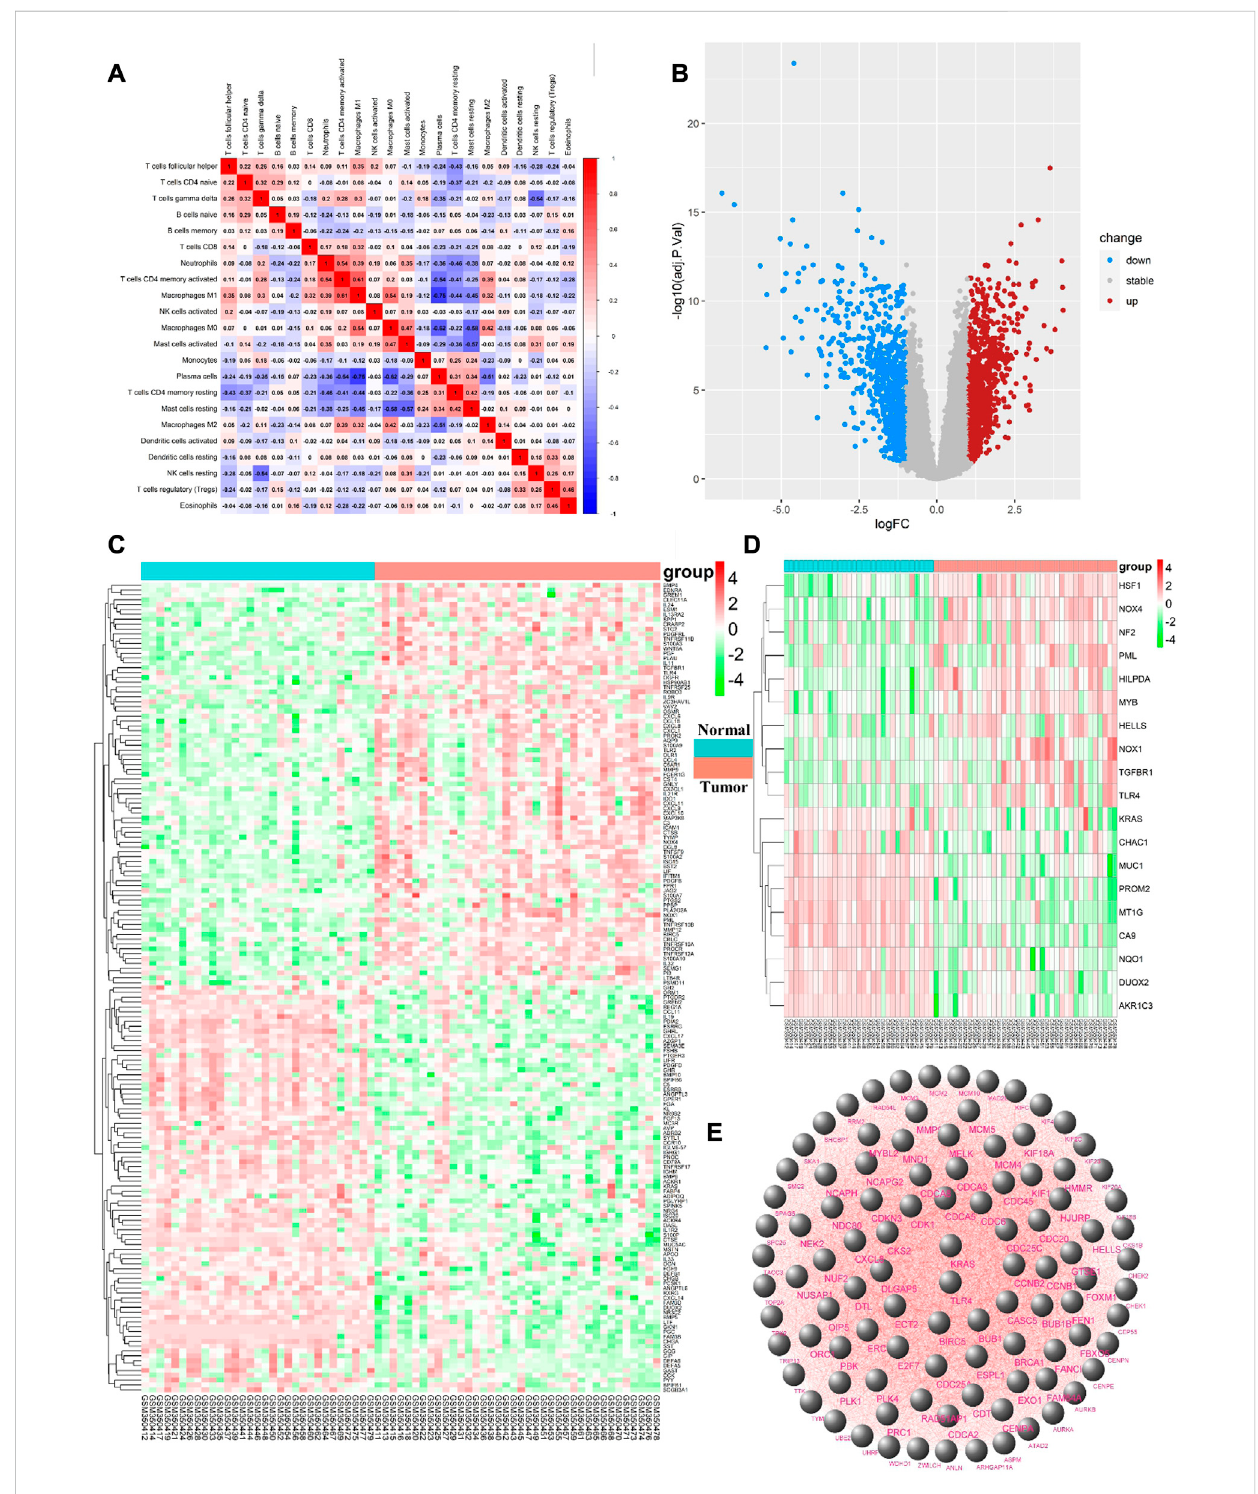
FIGURE 2 (A) the vertical axis and horizontal axis both represent the type of immune cells, and the value in each cell represents the correlation degree of the two immune cells. The higher the correlation, the redder the color; (B) . Upregulated DEGs are highlighted in red and downregulated DEGs in blue. Criteria: |logFC| ≥ 1 and adjPvalue ≤ 0.05; (C) . Expression levels of 167 ImmDEGs are shown, thedarker the redcolor, thehigher theexpression level, and thedarkerthegreencolor,thelowertheexpressionlevel.Congroup=normaltissue;trialgroup=tumortissue; (D) .Sameas (C) ,expressionlevelsof 19 FerDEGs are shown; (E) . The PPI network was